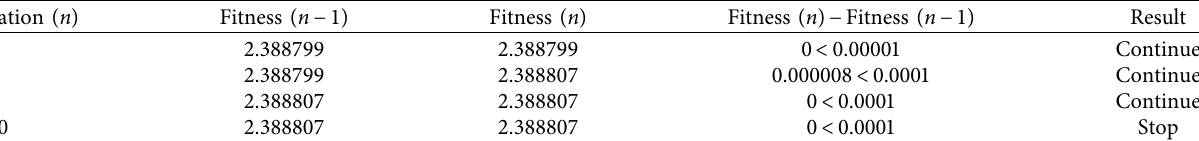
Table 3: Optimization calculation process of the QPSO.